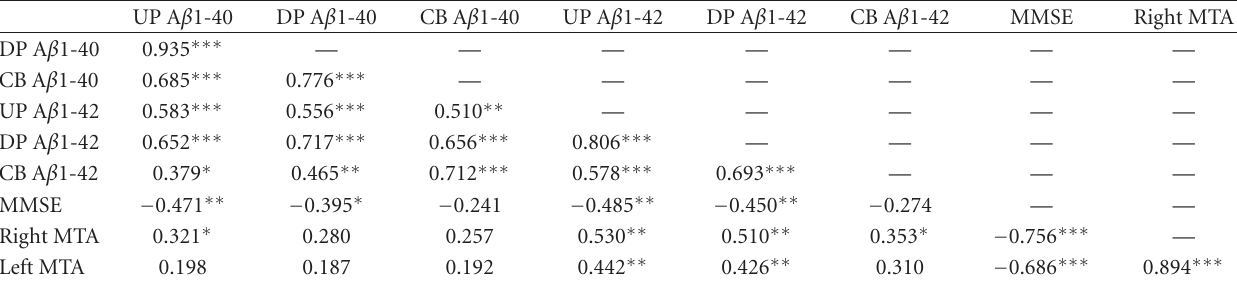
Table 3: Correlation between